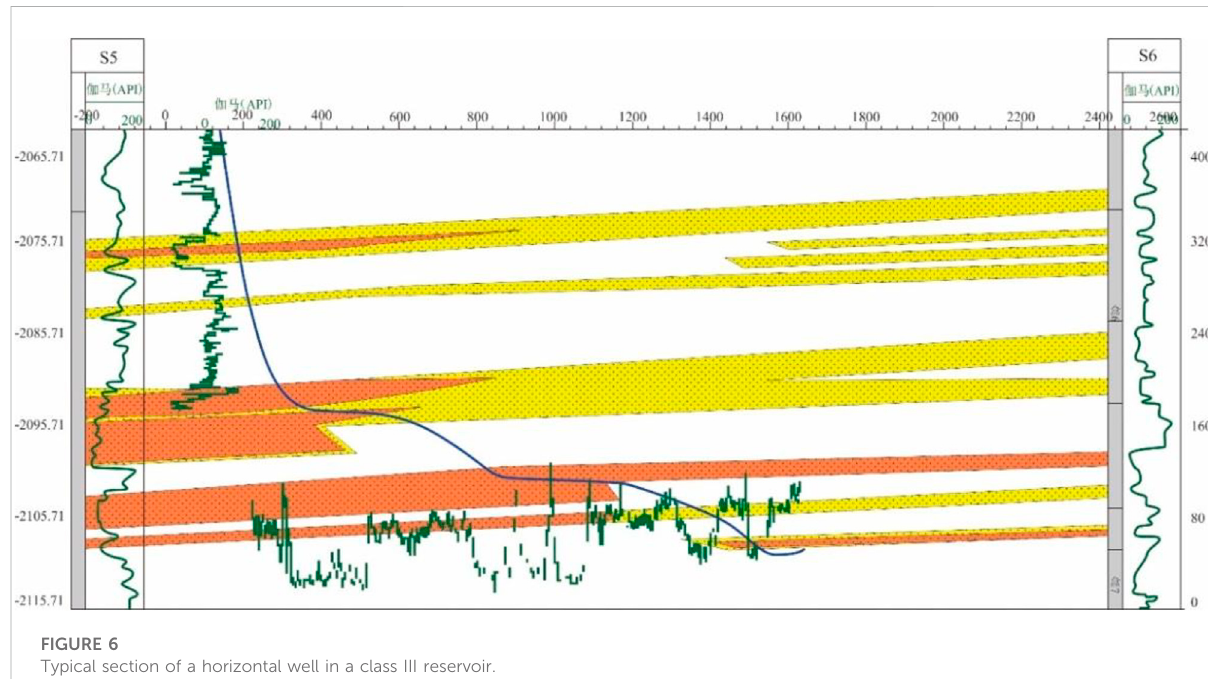
FIGURE 6 Typical section of a horizontal well in a class III reservoir.